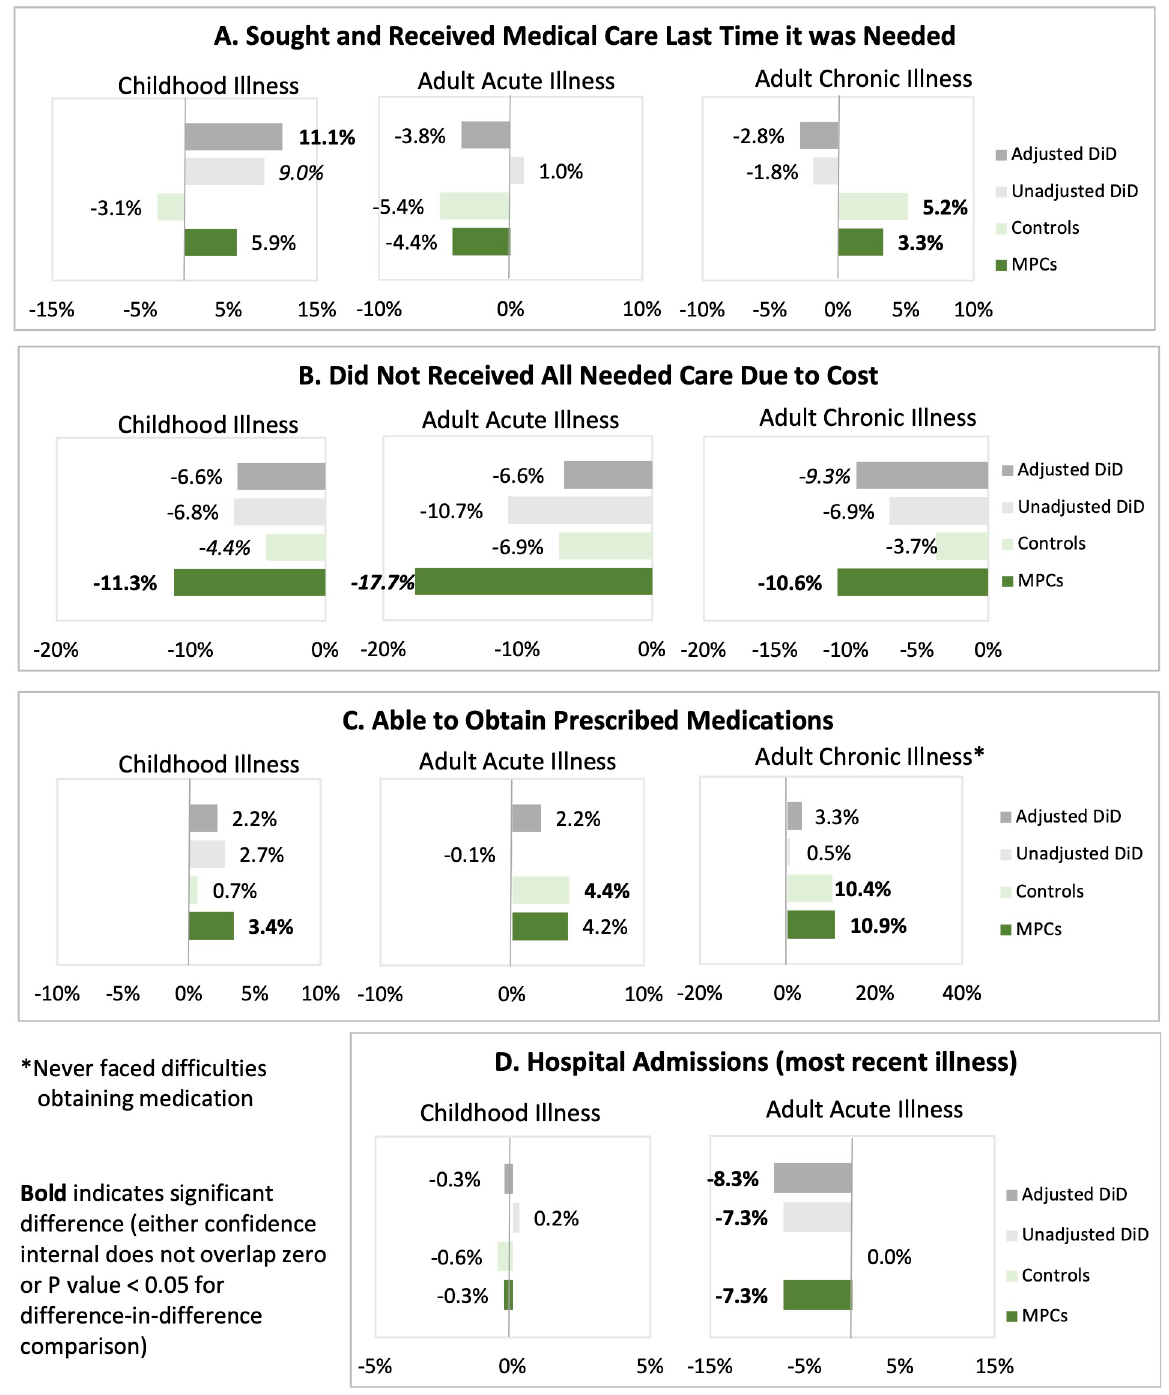
Fig 2. Change in health utilization measures by group and difference in magnitude of change between